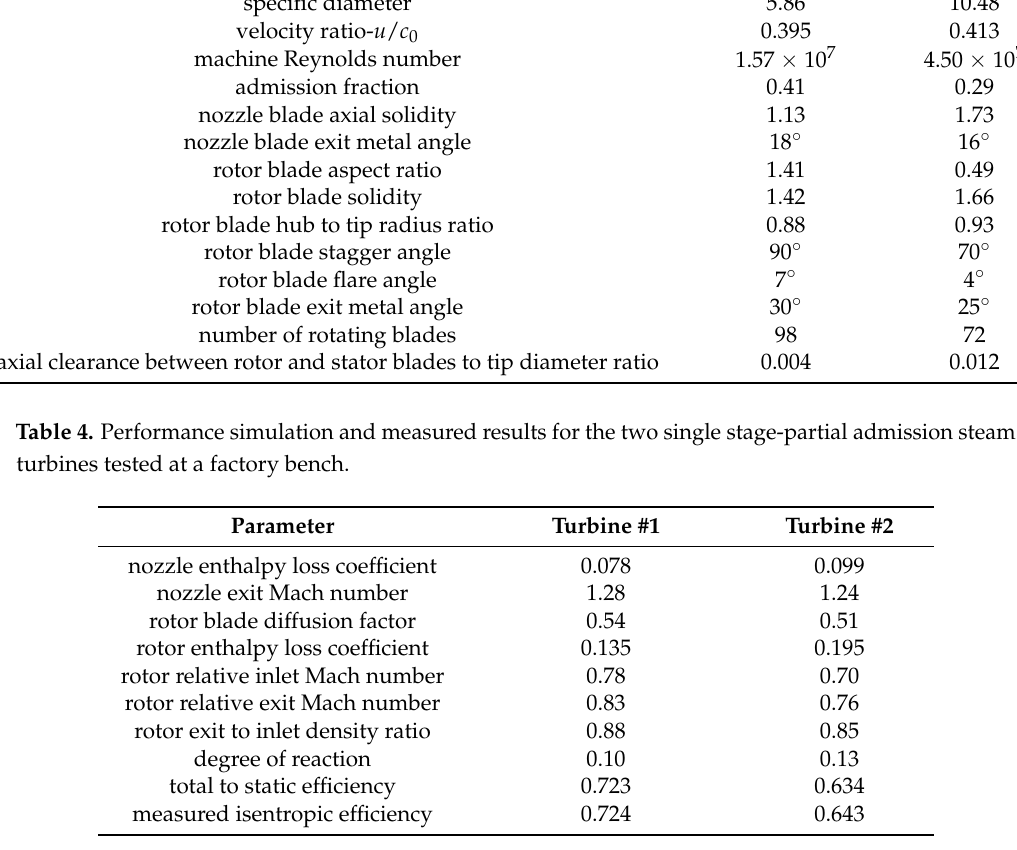
Table 5. Simulated loss breakdown for the two single-stage partial admission steam turbines tested at a factory